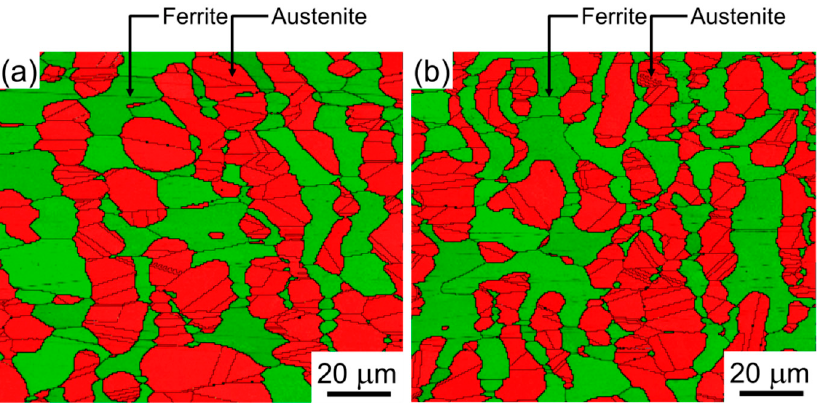
Figure 4. Electron backscatter di ff raction (EBSD) phase maps of the ( a ) DSS-N and ( b ) DSS-NC. Figure 4. Electron backscatter diffraction (EBSD) phase maps of the ( a ) DSS-N and ( b ) DSS-NC. The The grain boundaries were identified with the critical misorientation angle of > 10 ◦ . (red: Sace-centered grain boundaries were identified with the critical misorientation angle of >10°. (red: Sace-centered Figure 4. Electron backscatter diffraction (EBSD) phase maps of the ( a ) DSS-N and ( b ) DSS-NC. The cubic ( γ ) and green: Body centered cubic ( α cubic ( γ ) and green: Body centered cubic ( α ). grain boundaries were identified with the critical misorientation angle of >10°. (red: Sace-centered Figure 4. Electron backscatter diffraction (EBSD) phase maps of the ( a ) DSS-N and ( b ) DSS-NC. The cubic ( γ ) and green: Body centered cubic ( α ). grain boundaries were identified with the critical misorientation angle of >10°. (red: Sace-centered cubic ( γ ) and green: Body centered cubic ( α ).